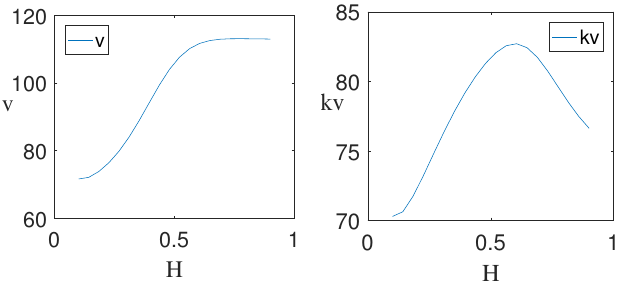
Figure 1. The effect of different H on v and kv when S = 70.